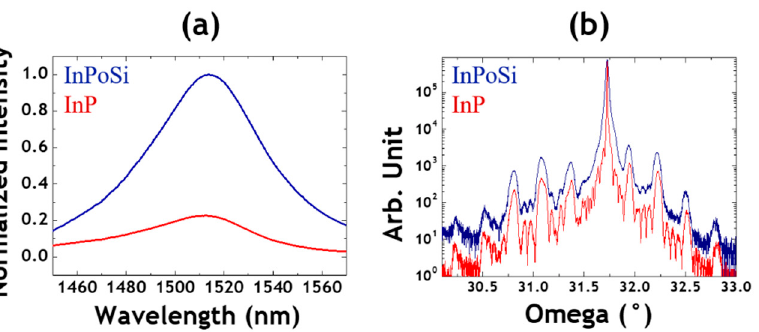
Figure 4. Characterizations done on the laser structures grown on InPoSi (blue) and on InP (red): ( a ) normalized intensity of the photoluminescence signals; ( b ) HRXRD profiles.